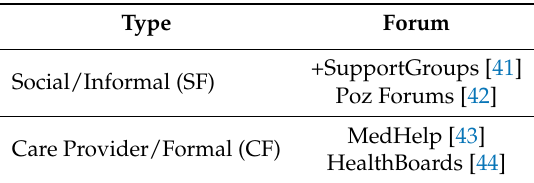
Table 1. Online HIV support